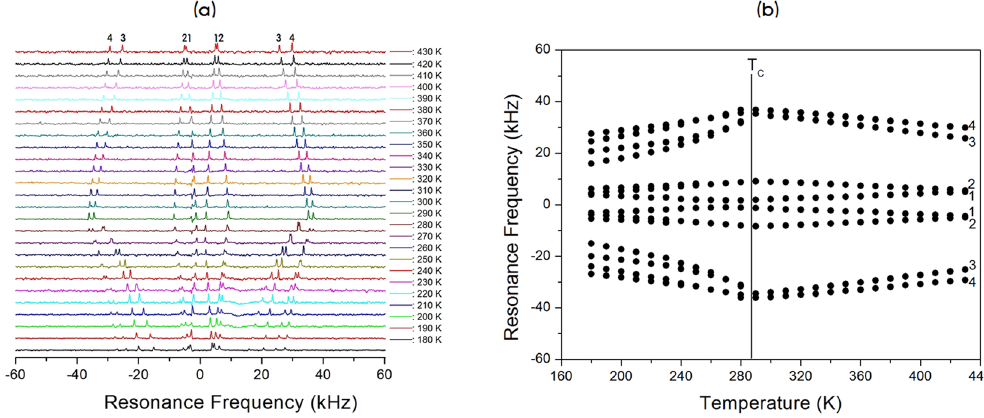
Figure 9. ( a ) In-situ 14 N NMR spectrum as a function of temperature for [N(CH 3 ) 4 ] 2 Zn 1- x Cu x Br 4 ( x = 0.5). ( b ) Resonance frequency of the 14 N NMR spectrum as a function of temperature for [N(CH 3 ) 4 ] 2 Zn 1- x Cu x Br 4 ( x =